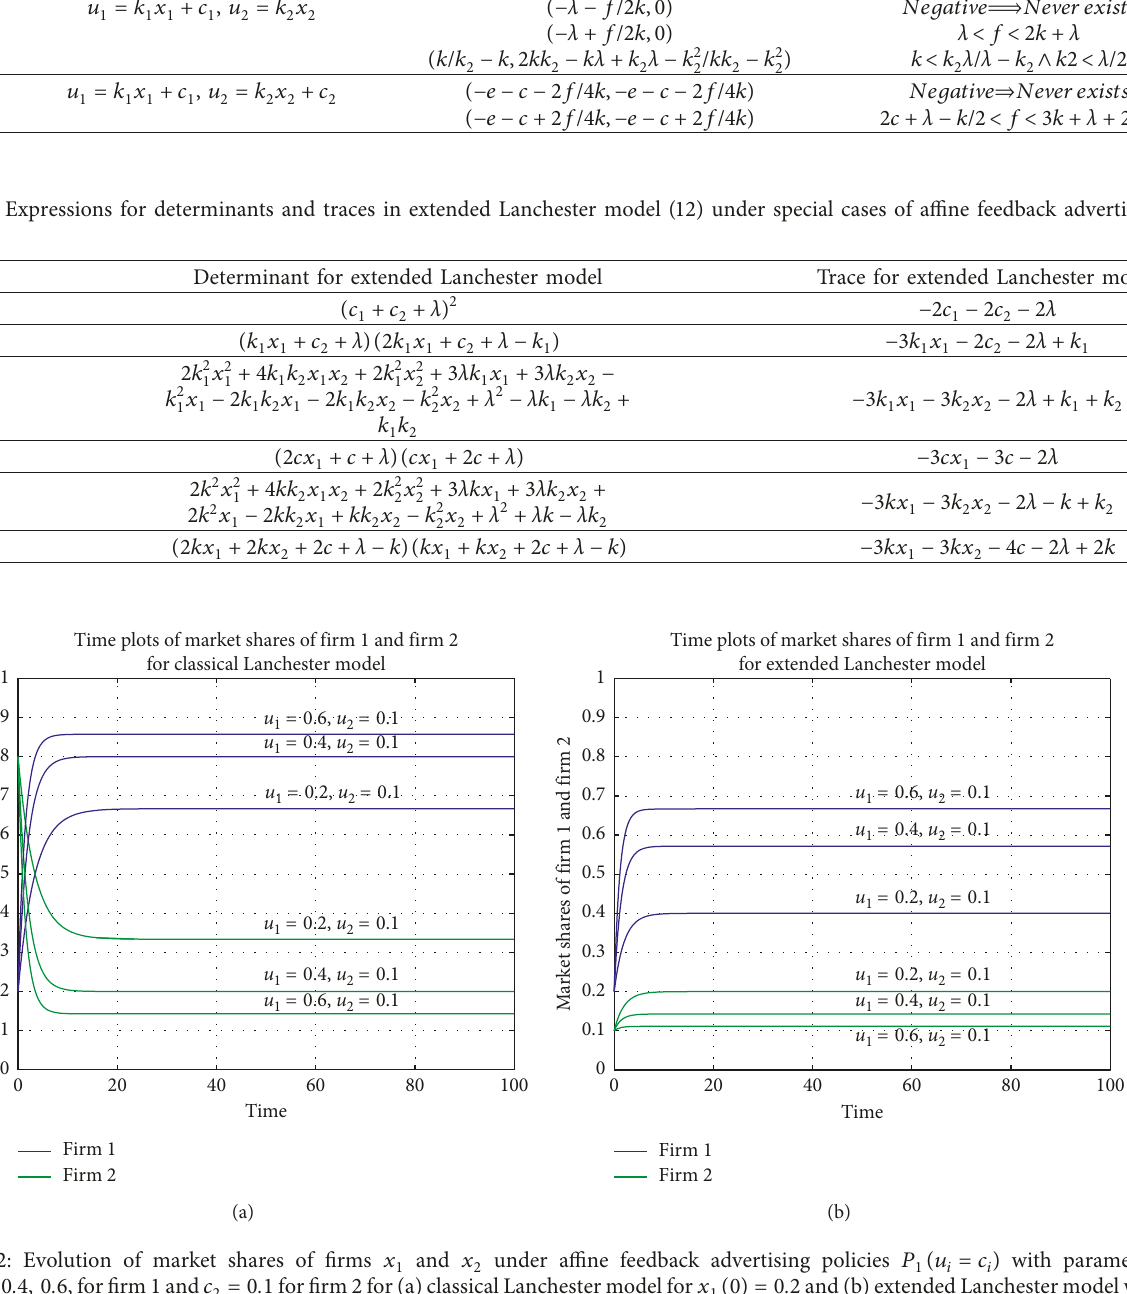
( 0 ) � 0 . 2 and (b) extended Lanchester model with 1